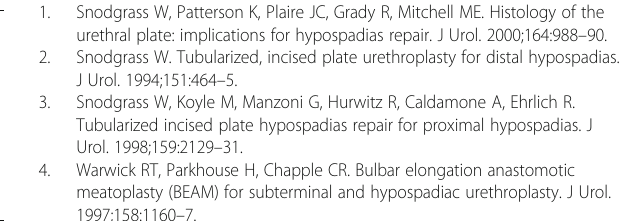
Table 10 Need for additional procedures after surgery Need for additional procedures n = 52 Suprapubic cystostomy 2 (4%) Meatotomy/meatoplasty 2 (4%) Fistula closure 4 (8%) Reoperative procedure for residual VC 1 (2%) Redo repair: partial Redo urethroplasty: